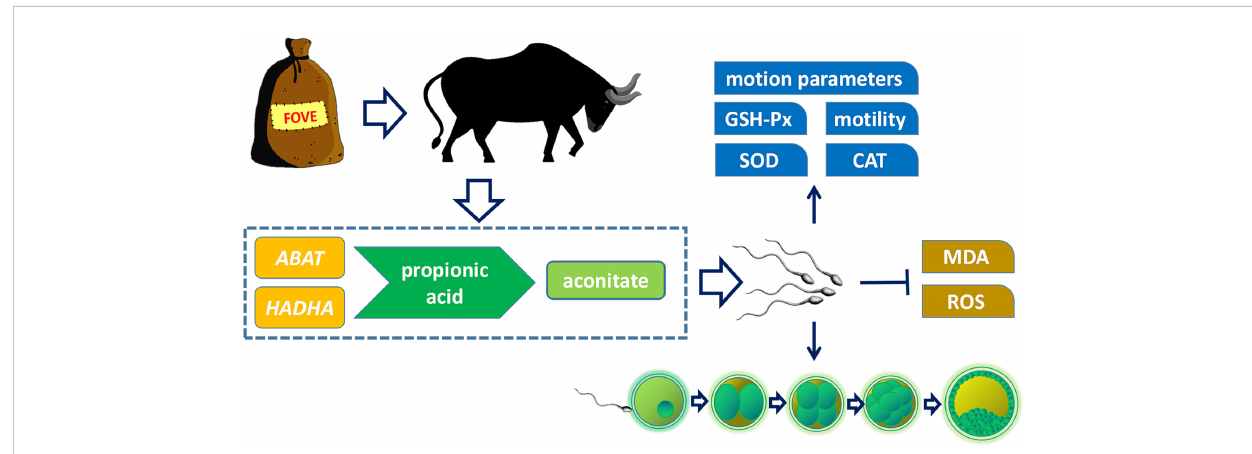
FIGURE 8 Effects of dietary supplementation of FO and VE on semen quality of bulls. The combination of FO and VE in diet can improve frozen-thawed sperm motility, motion parameters, antioxidant capacity and in vitro fertilization ability, which may be caused by the regulation of ABAT and HADHA genes and aconitate content in propionic acid metabolism